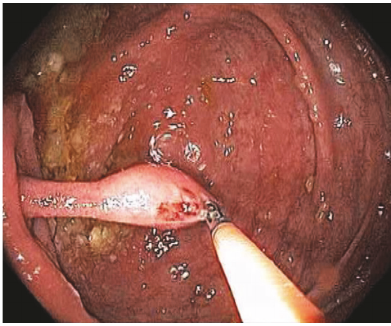
Figure 34: Endoscopic image of a pedunculated intraluminal lipoma arising from the terminal ileum.